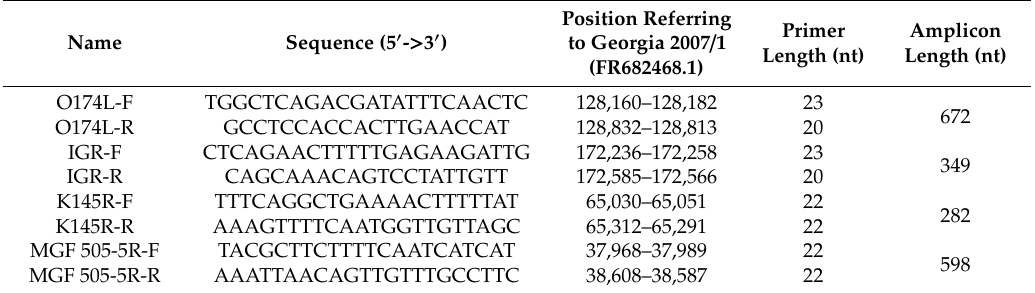
Table 1. Characteristics of the primers used in the study. Amplification products of O174L covers the whole encoded gene, whereas K145R and MGF 505-5R primers were designed to cover only the regions containing the nucleotide of the